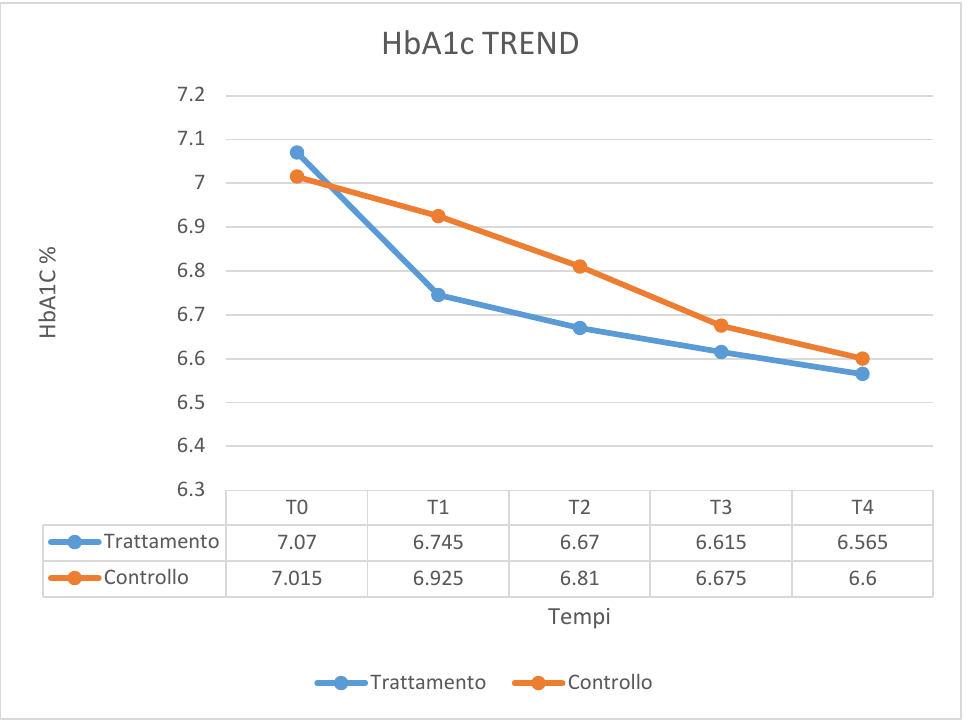
Figure 1. The fluctuation in the HbA1C means over time.